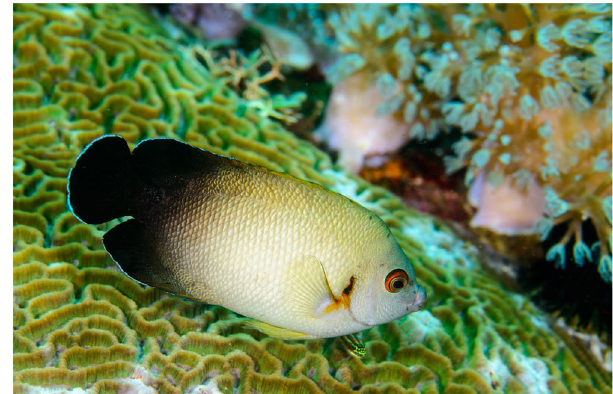
Figure 1. The Pearlscale Pygmy Angelfish, Centropyge vrolikii .